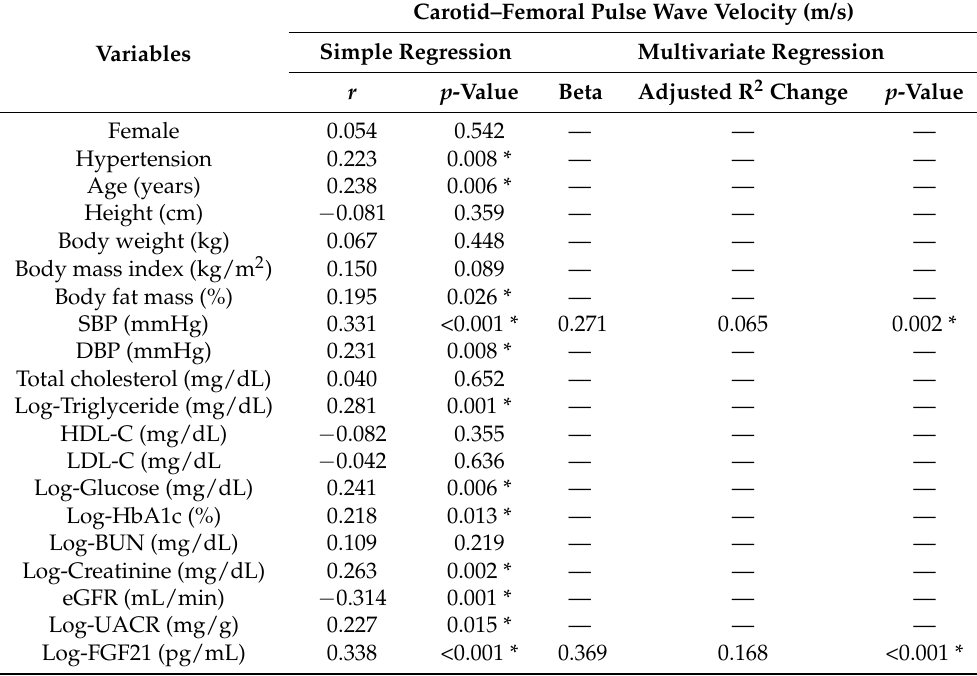
Table 3. Correlation between carotid–femoral pulse wave velocity levels and clinical variables among the 130 DM patients.